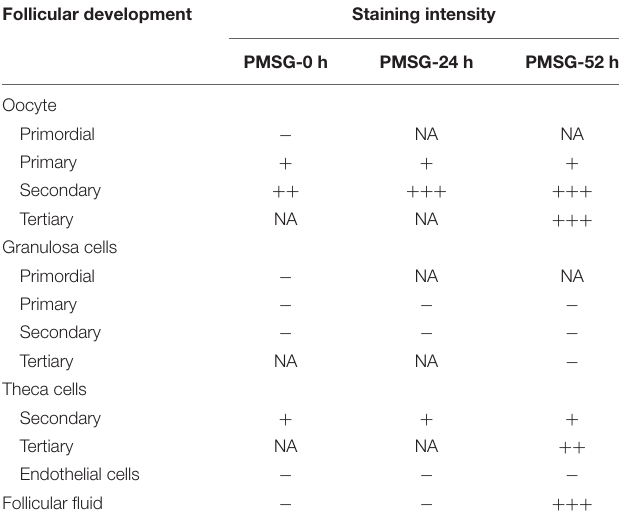
TABLE 3 | Relative abundances of IL-1 β in the ovary during follicular development induced by PMSG.